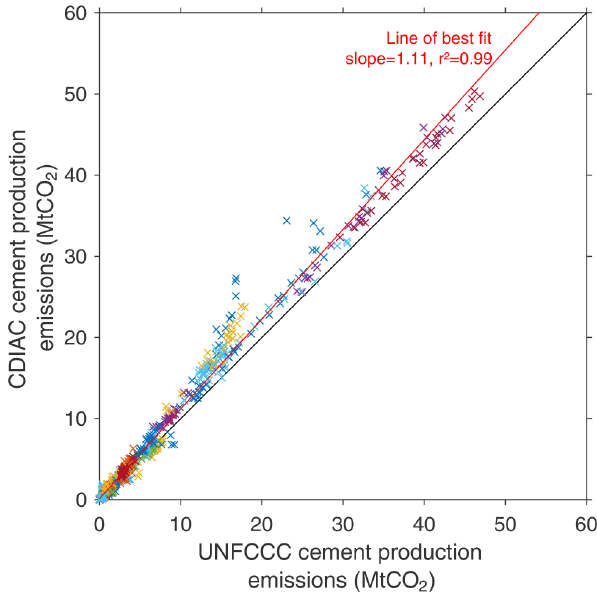
Figure A2. Comparison of CO 2 emissions in 43 countries as esti- mated by CDIAC (Boden et al., 2013) and those officially reported to the UNFCCC, 1990–2012 (UNFCCC,